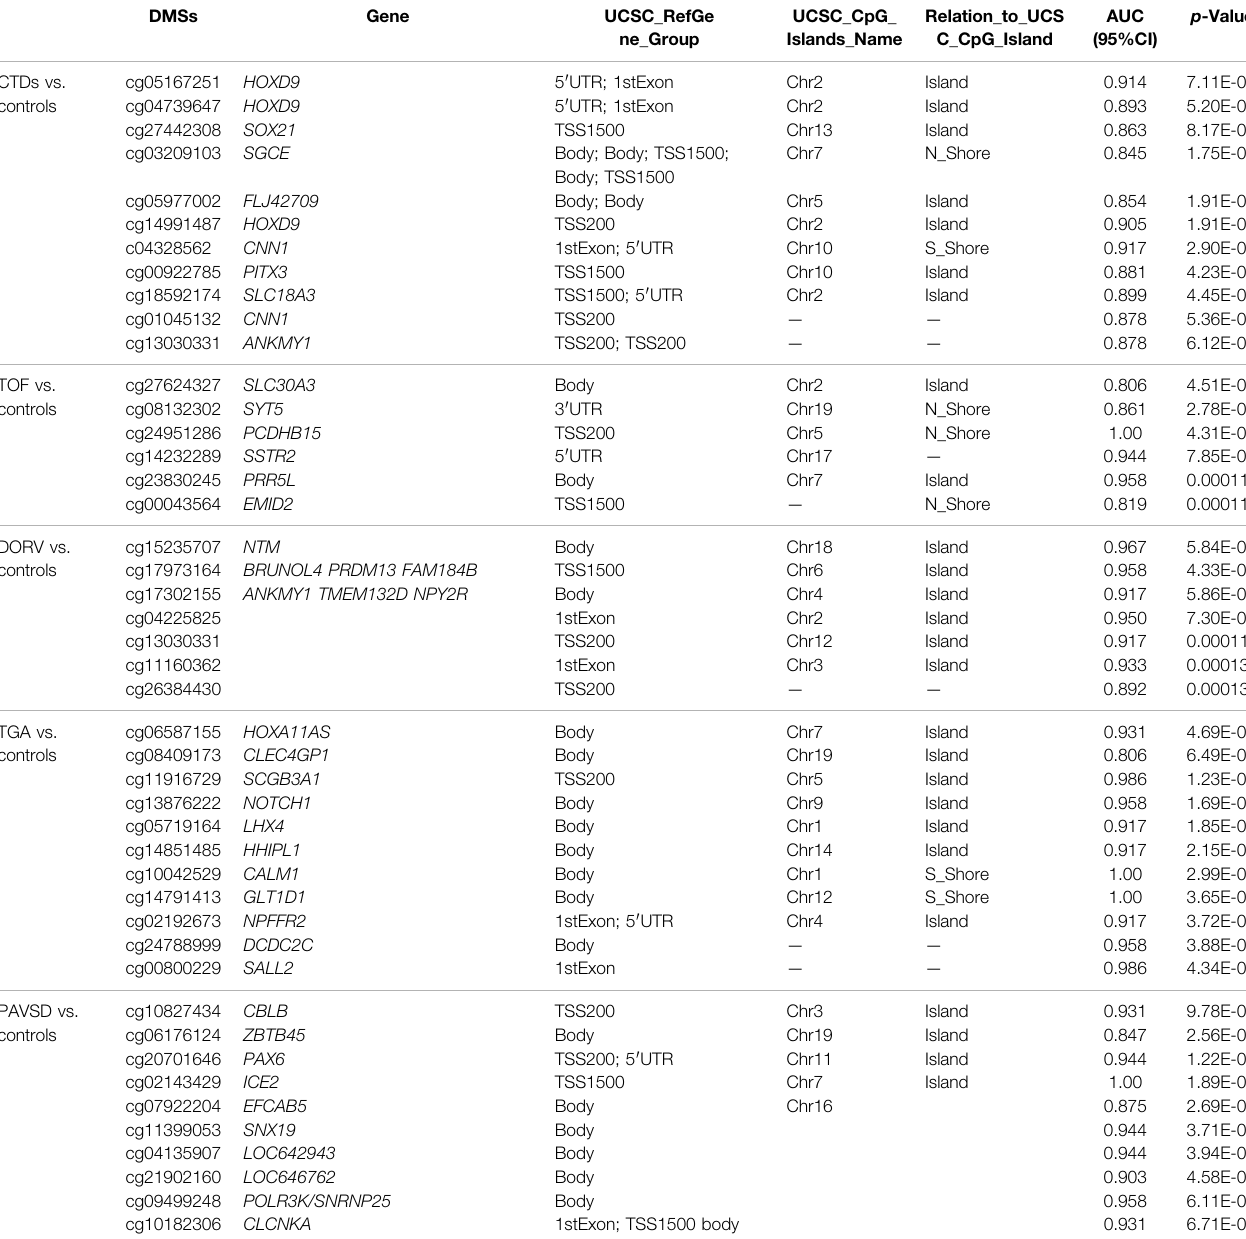
TABLE 2 | The top DMSs between groups and AUC of epigenetic markers of each group. DMSs Gene